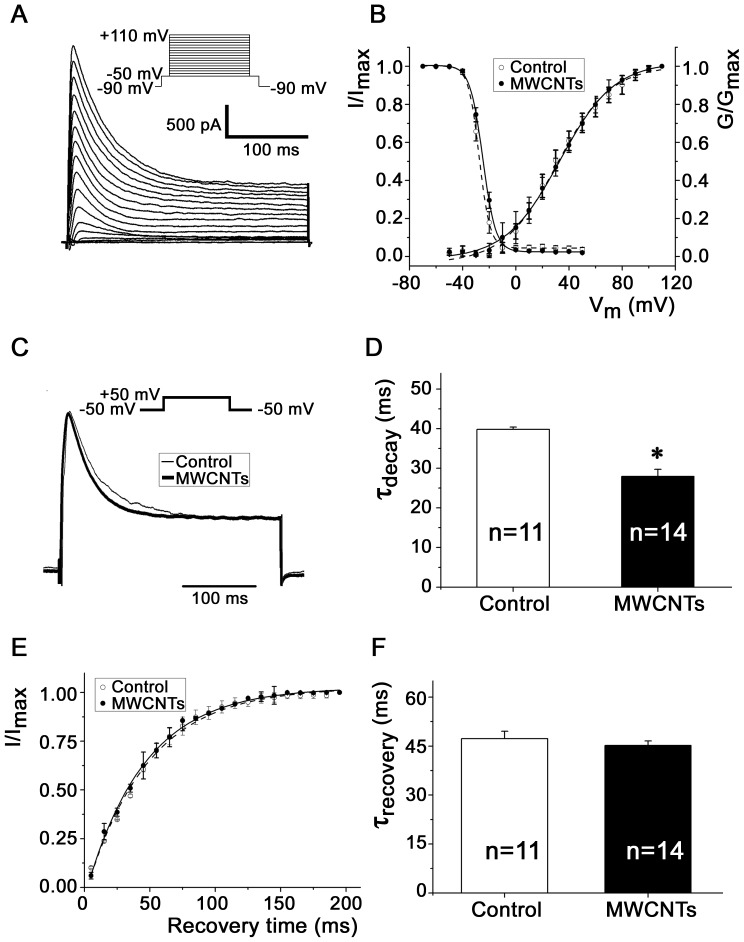
Effects of MWCNTs on the I
to of isolated rat ventricular myocytes.
A, a typical example of I
to recorded from ventricular myocytes. B, voltage-dependent activation and inactivation curves of I
to from rat ventricular myocytes with or without (control) MWCNTs (20 µg/ml) incubation. C, comparison of the I
to traces and τdecay in rat ventricular myocytes with (thick) or without (thin) MWCNTs treatment. Ventricular myocytes were depolarized from −50 mV to +50 mV. D, statistical data of the τdecay of ventricular myocytes with or without MWCNTs treatment. E, I
to recovery curves. F, statistical τrecovery bar graphs of control cells and MWCNT-treated cells. * P<0.05 vs. control.